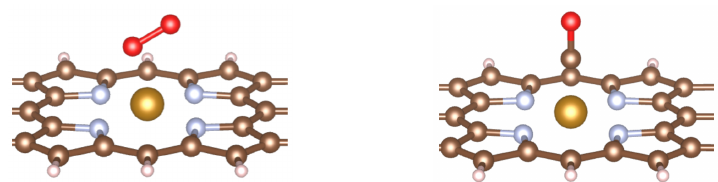
Figure 12. FeP junction with the adsorbed O 2 ( left panel ) and CO ( right panel ) molecules.